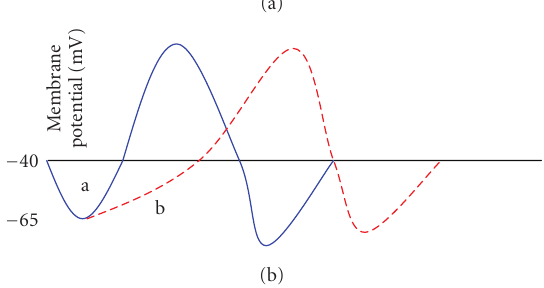
Figure 1: (a) a diagram demonstrates I f current and other ionic currents in phase 4 of action potential. For simplicity I caL and I caT are shown together as I ca . (b) Inhibition of I f phase 4 of action potential leads to reduction of slope from a to b. This results in prolonged phase 4 or firing frequency of action potential, thus slower heart